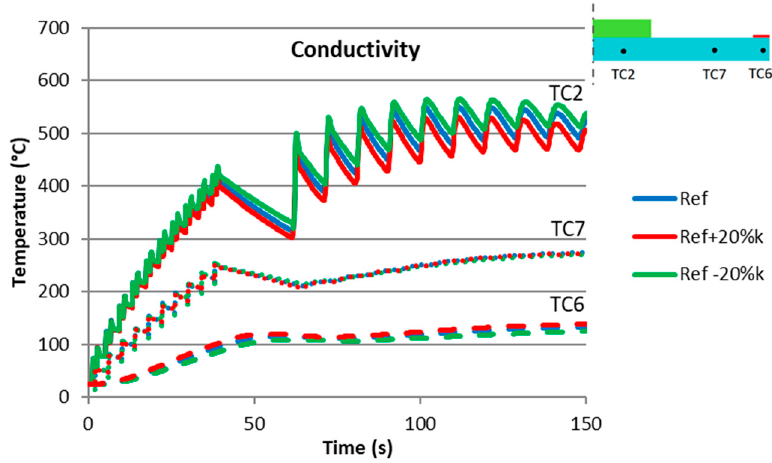
Figure 16. Sensitivity of substrate conductivity variation on the thermal history.